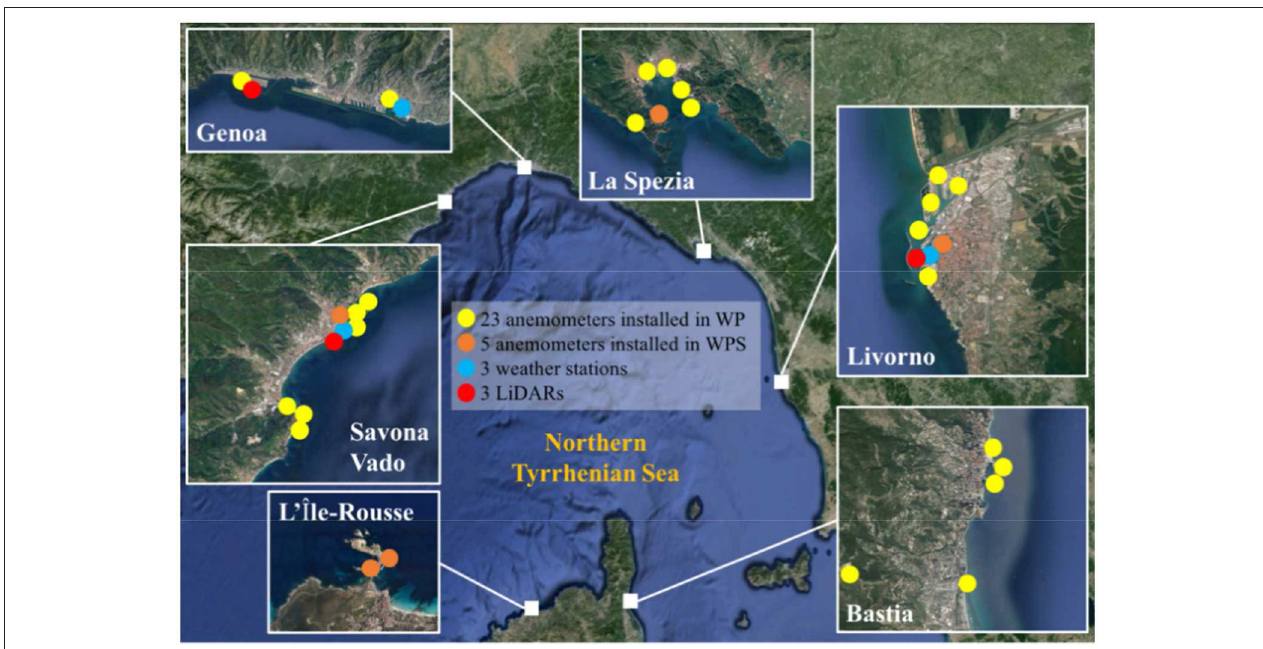
FIGURE 8 | WP &WPS wind monitoring network. Reproduced from Zhang et al. (2018a) with permission from